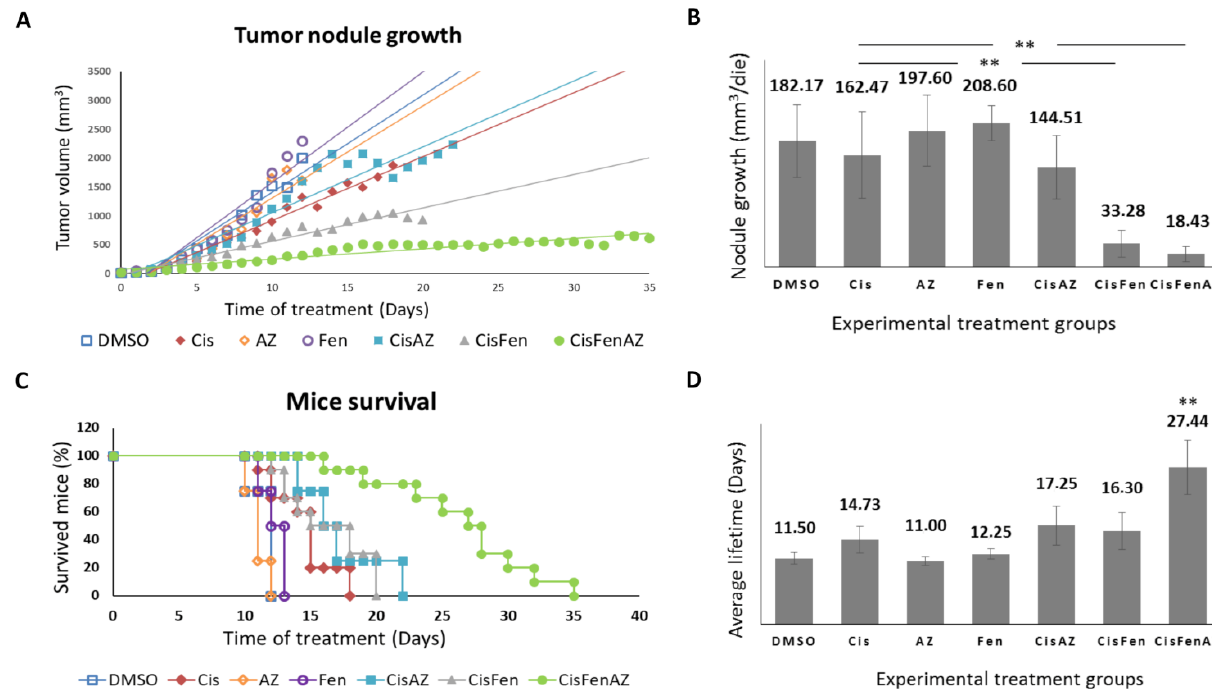
Figure 1. Tumor nodule growth and mice survival. Once SKNBE2 mass reached 5 mm in diameter, mice were treated with DMSO, Cisplatin 5 mg/kg (Cis); acetazolamide 20 mg/Kg (AZ); fendiline hydrochloride 3 mg/kg (Fen); cisplatin 5 mg/kg in co-administration with acetazolamide 20 mg/Kg (CisAZ); cisplatin 5 mg/kg in co-administration with fendiline hydrochloride 3 mg/kg (CisFen); cisplatin 5 mg/kg in co-administration with fendiline hydrochloride 3 mg/kg and acetazolamide 20 mg/Kg (CisFenAZ). The graphs depict linear trend lines of nodule tumor volume ( A ) and average growth of the nodule per day ( B ) in each experimental group. In ( C ), the Kaplan – Meier plot indicates the percentages of mice survival at increasing days after the beginning of treatments. A highly statistically significant decrease of mass growth is induced by CisFen and CisFenAZ treatments (** p < 0.001). The histograms in ( D ) represent the average lifetime of mice for each treatment group. A highly statistically significant increase of survival is induced by CisFenAZ (** p < 0.001). To compare differences between experimental groups, statistical analysis was performed using one-way analysis of variance (ANOVA) followed by Tukey post hoc test.